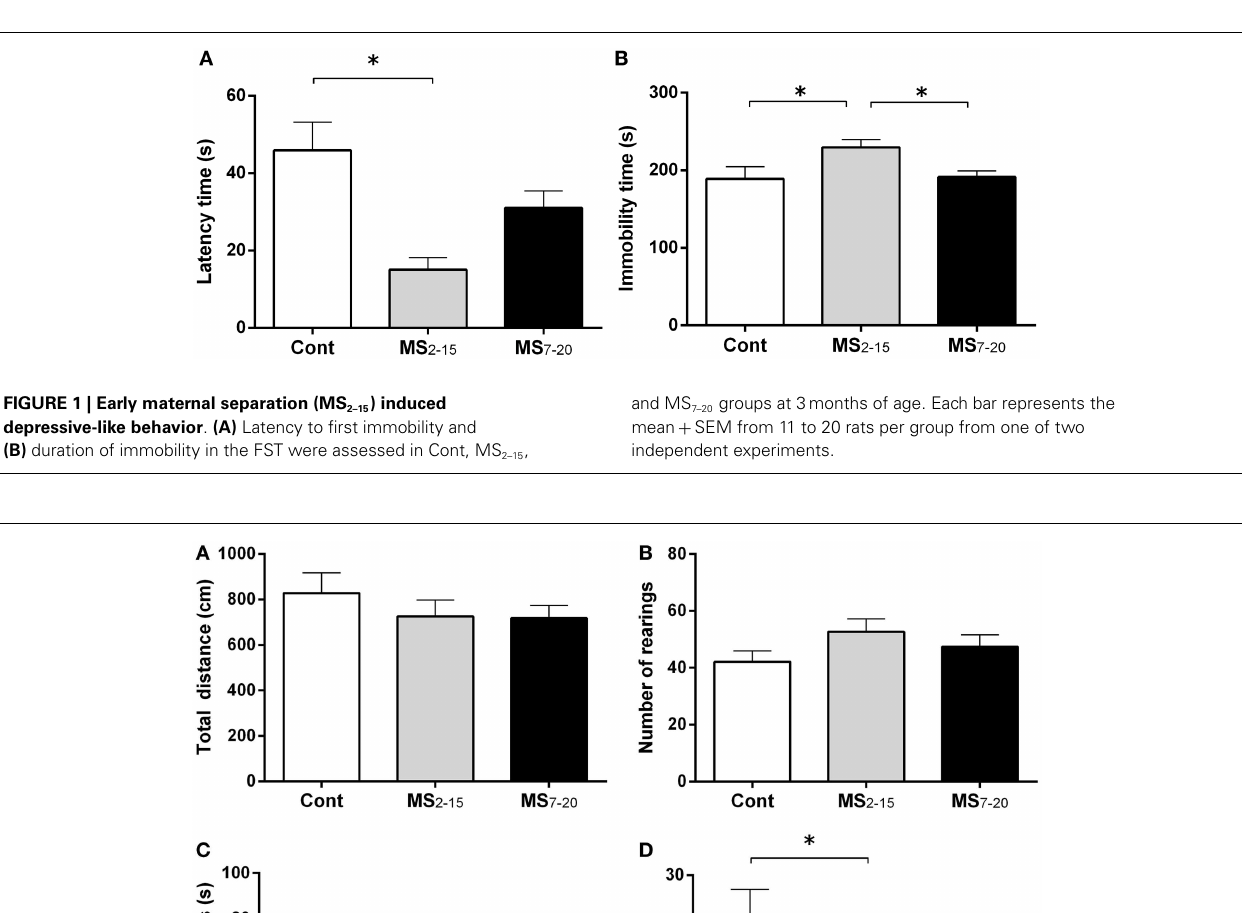
Cont, MS 2–15 , and MS 7–20 groups at 3months of age. Each bar represents the mean + SEM from 11 to 20 rats per group from one of two independent